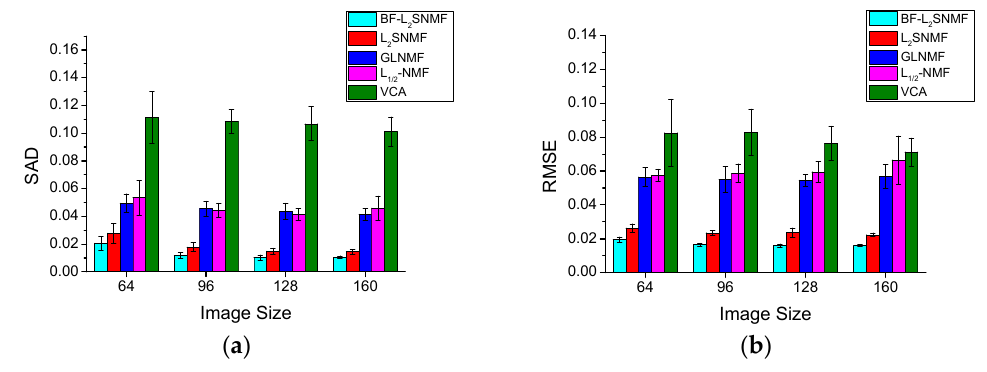
sized simulation images. Figure 6 shows